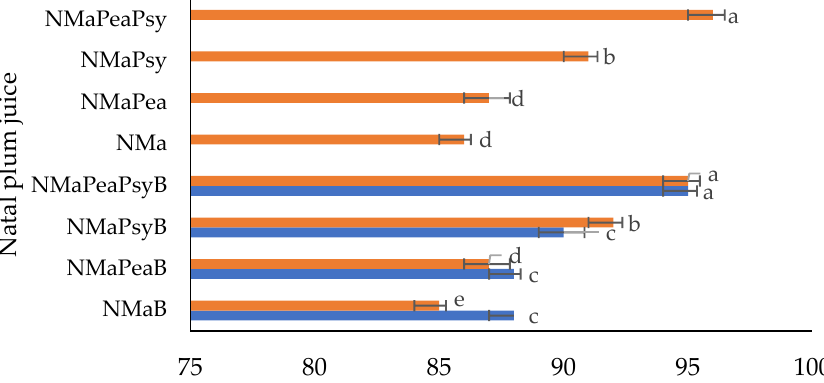
Figure 2. Lactic acid bacteria and anthocyanin encapsulation efficiency of co-encapsulated Natal plum ( Carissa macrocarpa ) juice. Error bars show the standard deviation value; bars with different letter are significantly different p < 0.05. Key: NMa: Natal plum ( Carissa macrocarpa ) juice + maltodextrin; NMaB: Natal plum ( Carissa macrocarpa ) juice + maltodextrin + Ltp. plantarum 75; NMaPea: Natal plum ( Carissa macrocarpa ) juice + maltodextrin + pea protein isolate; NMaPeaB: Natal plum ( Carissa macrocarpa ) juice + maltodextrin + pea protein isolate + Ltp. plantarum 75; NMaPsy: Natal plum ( Carissa macrocarpa ) juice + maltodextrin + psyllium mucilage; NMaPsyB: Natal plum ( Carissa macrocarpa ) juice + maltodextrin + psyllium mucilage + Ltp. plantarum 75 ; NMaPeaPsy: Natal plum ( Carissa macrocarpa ) juice + maltodextrin + pea protein isolate + psyllium mucilage; NMaPeaPsyB: Natal plum ( Carissa macrocarpa ) juice + maltodextrin + pea protein isolate + psyllium mucilage + Ltp. plantarum 75